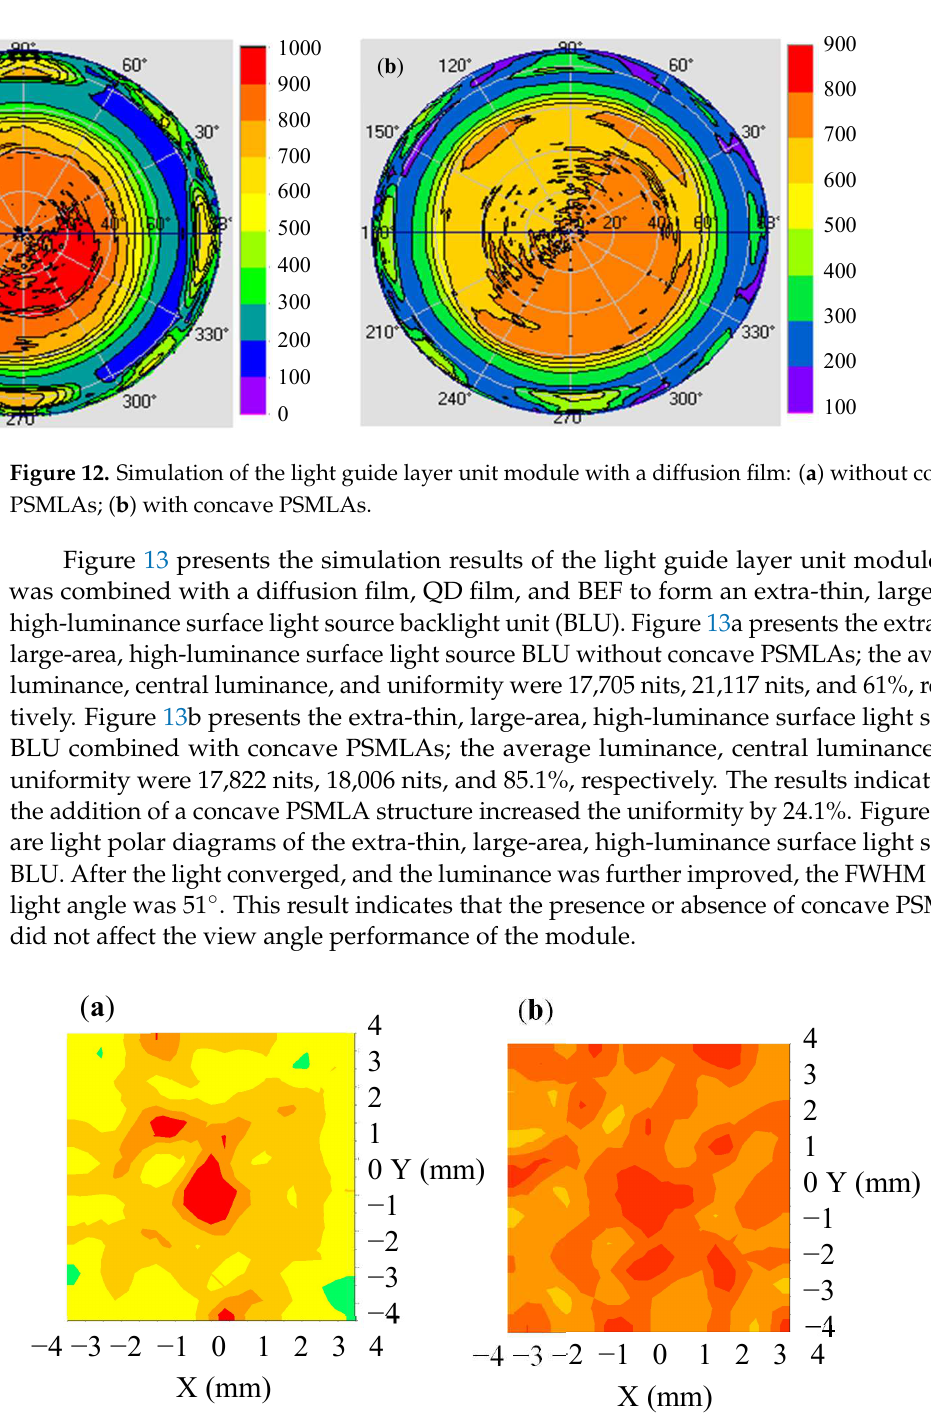
Figure 13. Simulation of an extra-thin, large-area, high-luminance surface light source backlight unit (BLU): ( a ) luminance distribution of a BLU without concave PSMLAs; ( b ) luminance distribu- tion of a BLU with concave PSMLAs; ( c ) light polar diagram of a BLU without concave PSMLAs; ( d ) light polar diagram of a BLU with concave PSMLAs. 3. Results and Discussion Figure 14 presents a sample of the light guide layer unit module. Figure 14a shows the light guide layer unit module without concave PSMLAs, and noticeable dark areas are present between the mini-LEDs. Figure 14b displays the light guide layer unit module that was combined with the concave PSMLAs, which considerably reduced the dark areas be- tween the mini-LEDs. Figure 14. Samples of the light guide layer unit module: ( a ) without PSMLAs; ( b ) with concave PSMLAs. Figure 15 plots the measured plane rectangular light distribution curves of the light guide layer unit module that was combined with a diffusion film. Figure 15a presents the results for the diffusion film that was combined with the light guide layer unit module without concave PSMLAs for which the FWHM of the light angle was 113°. Figure 15b